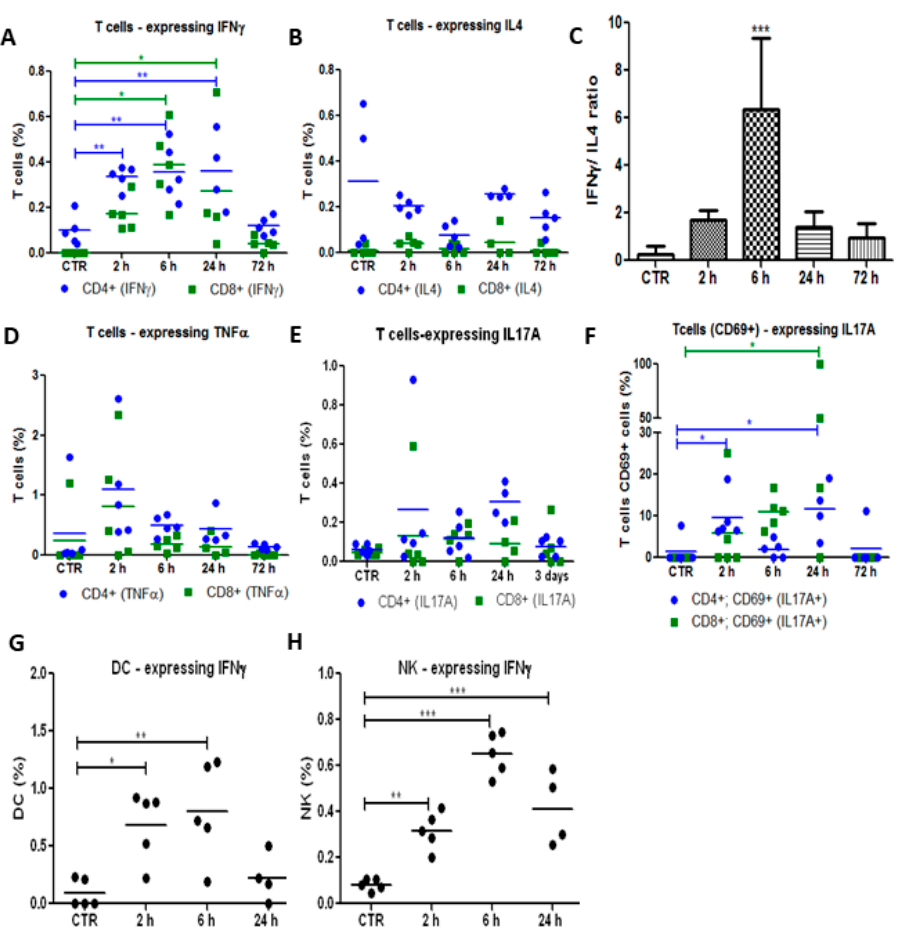
Figure 4. Redaporfin-PDT stimulates the production of IFN- γ and IL-17A by different immune cells. Production by T cells CD4 + (•) or CD8 + ( ▪ ) of ( A ) IFN- γ , ( B ) IL-4, ( D ) TNF- α and ( E ) , ( F ) IL-17A at different time points after redaporfin-PDT. ( C ) IFN- γ /IL-4 ratio, obtained by dividing IFN- γ -secreting CD4 + T cells by the IL-4-producing CD4 + T cells. ( G ) IFN- γ production by DC and ( H ) by NK. Bars are the mean ± SD of five mice. No symbol: p > 0.05; * p < 0.05; ** p < 0.01; *** p < 0.001.